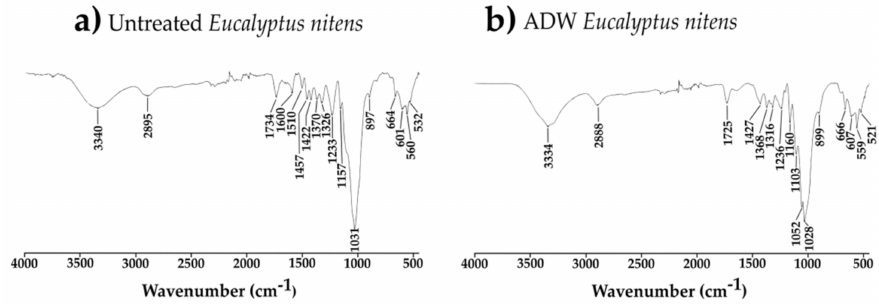
Figure 4. FT–IR spectra of ( a ) untreated and ( b ) ADW Eucalyptus nitens